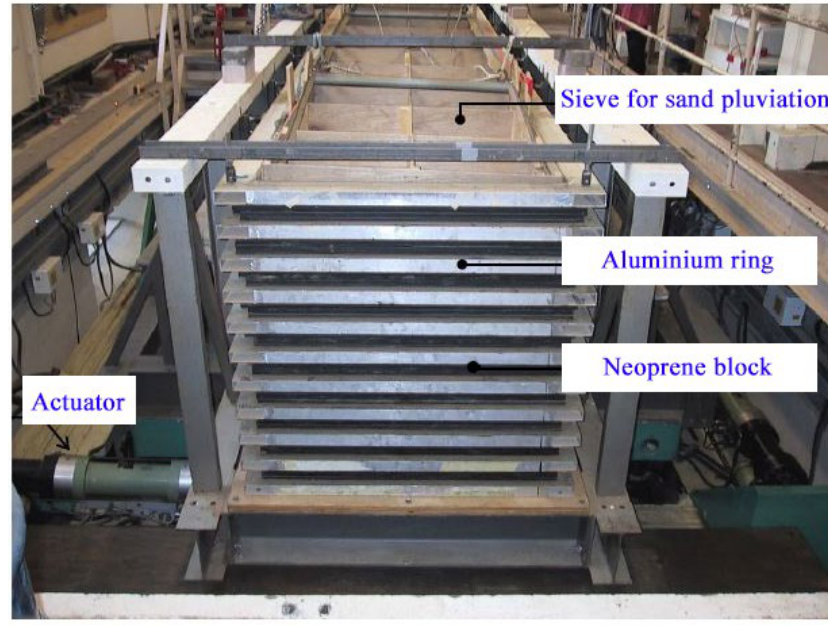
Figure 5. General view of the shear stack (From [5]; modified).